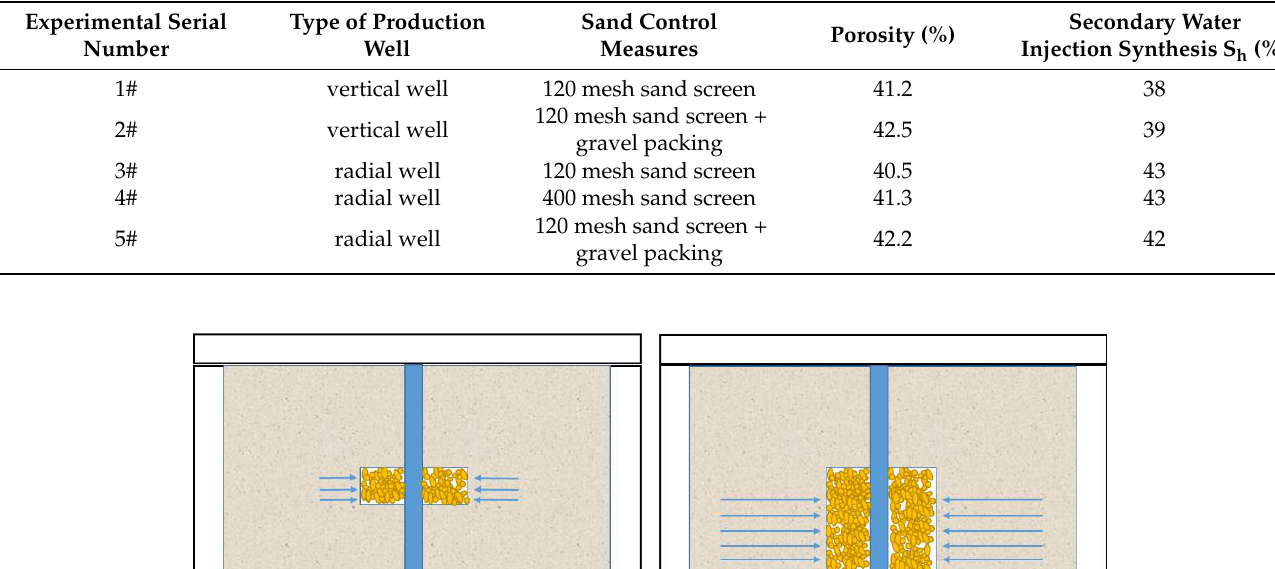
Table 1. Key parameters for natural gas production experiments.